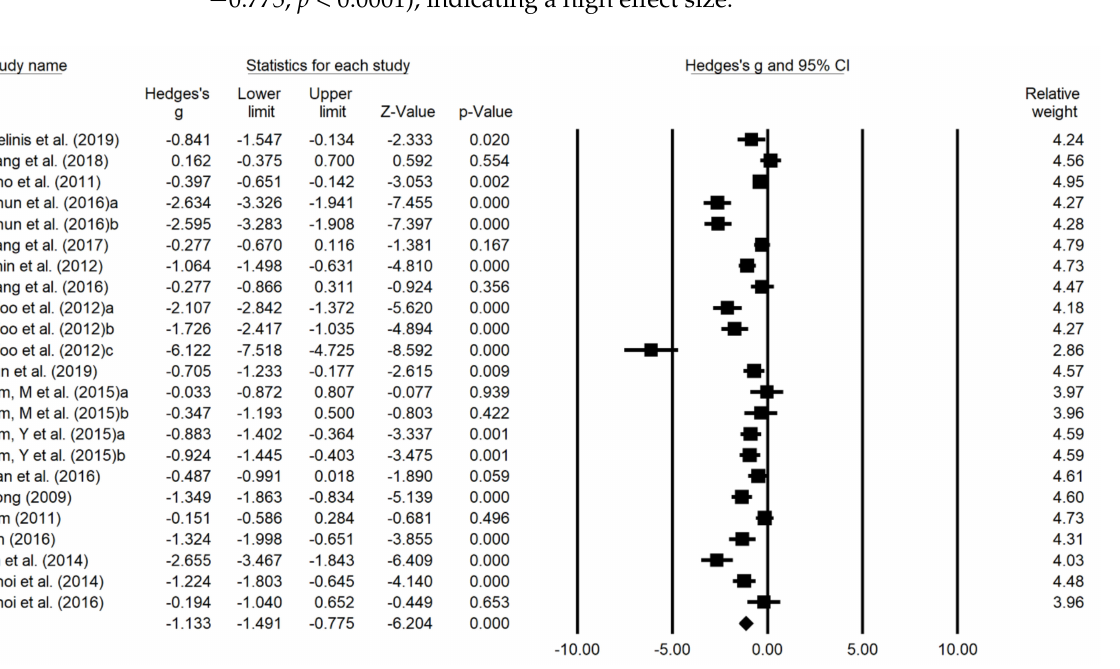
Figure 3. Forest plot the effects of forest therapy on depression. Heterogeneity: Tau 2 = 0.656; Q = 206.490; I 2 = 89.35%; Test overall effect Z = − 6.204 ( p < 0.001).